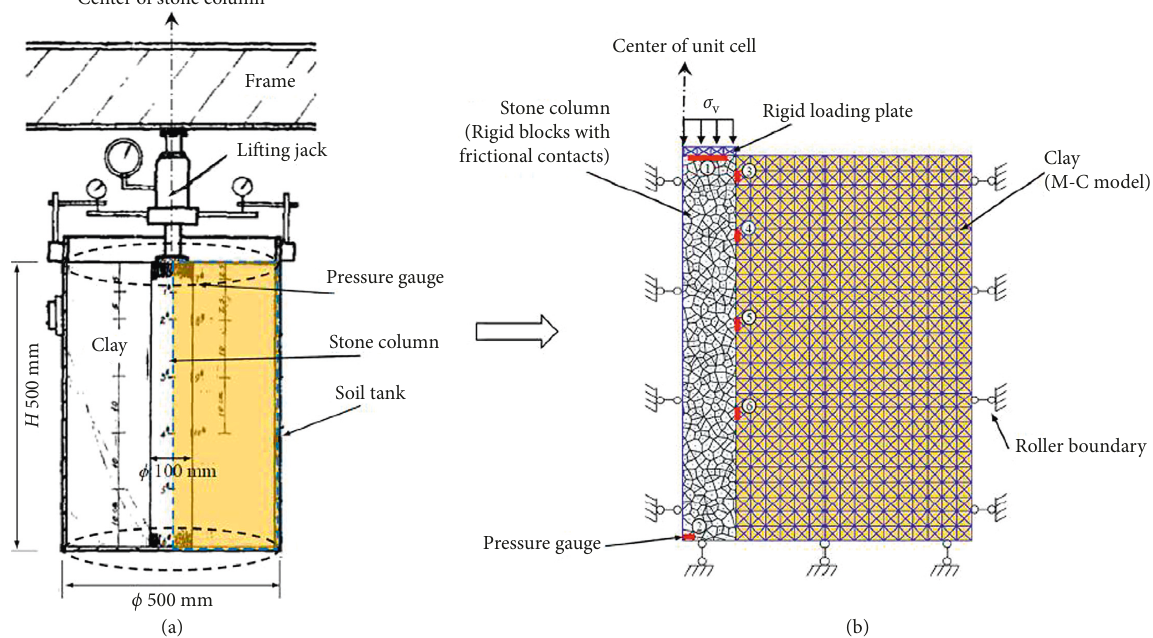
Figure 2: Conceptualization of the model from the experimental model to the numerical model. (a) Two-dimensional DEM-FDM model in UDEC [2]. (b) Experimental settings